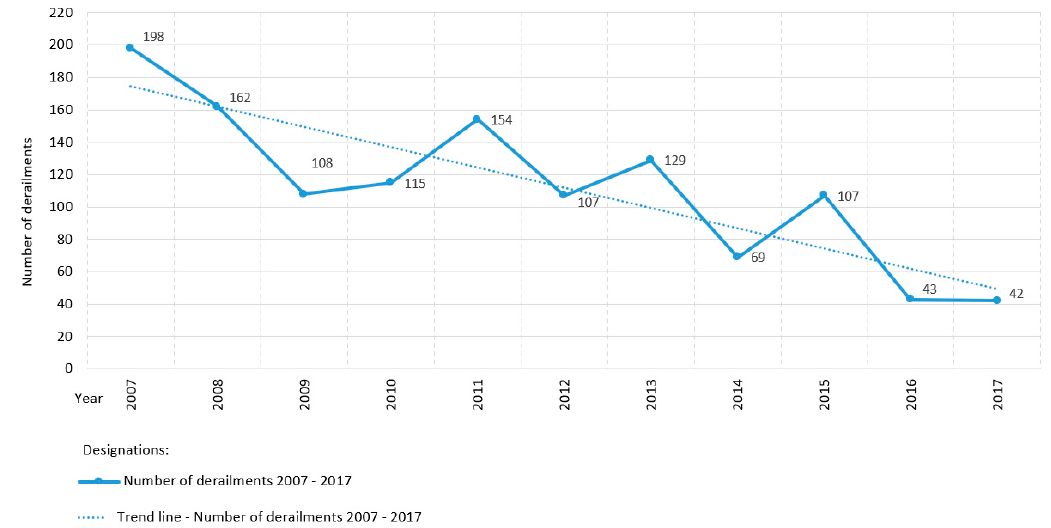
Figure 7. State of derailments on the railway network managed by PKP PLK S.A. in Poland in the years 2007–2017.